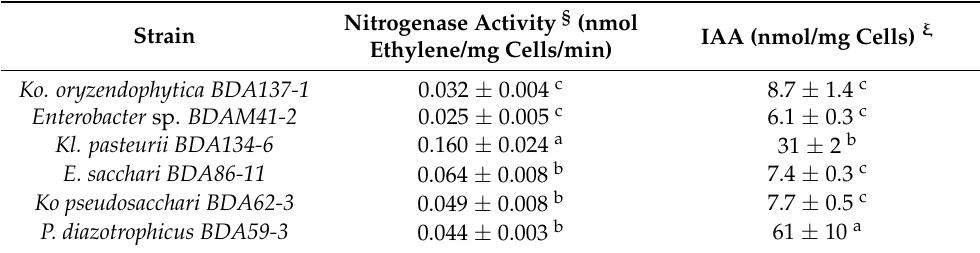
Table 1. Nitrogenase activity and IAA production in bacterial cultures of N-fixing endophytes isolated from O.